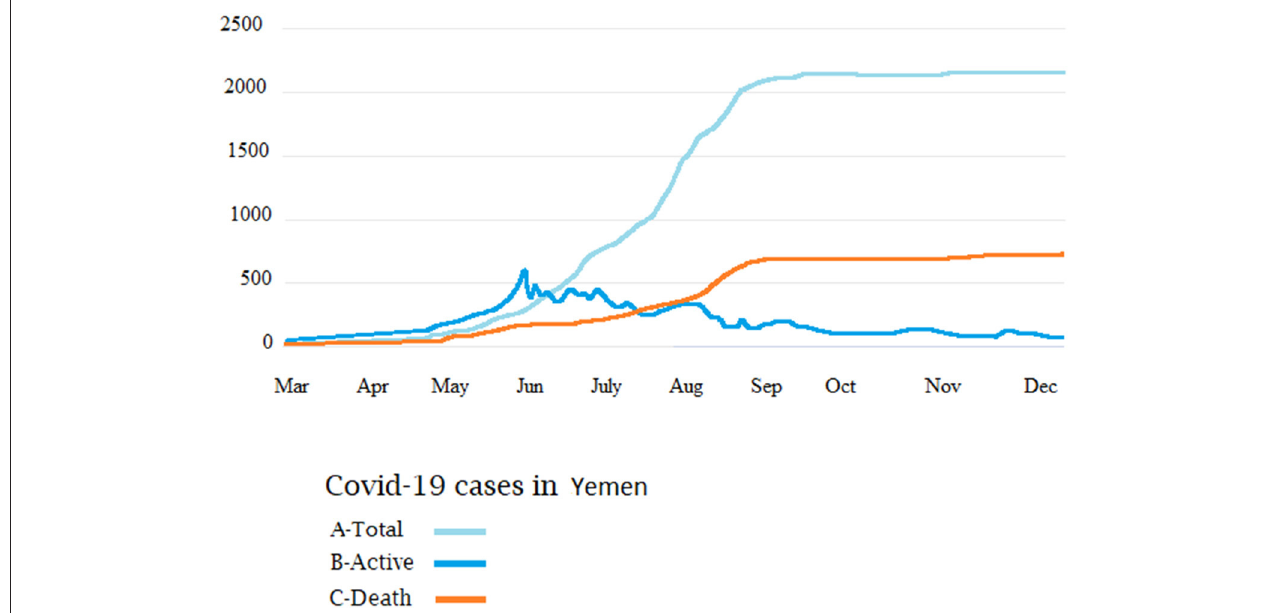
FIGURE 9 | Cumulative COVID-19 cases in Yemen. Total cases (A) , recoveries (B) , and number of deaths (C)